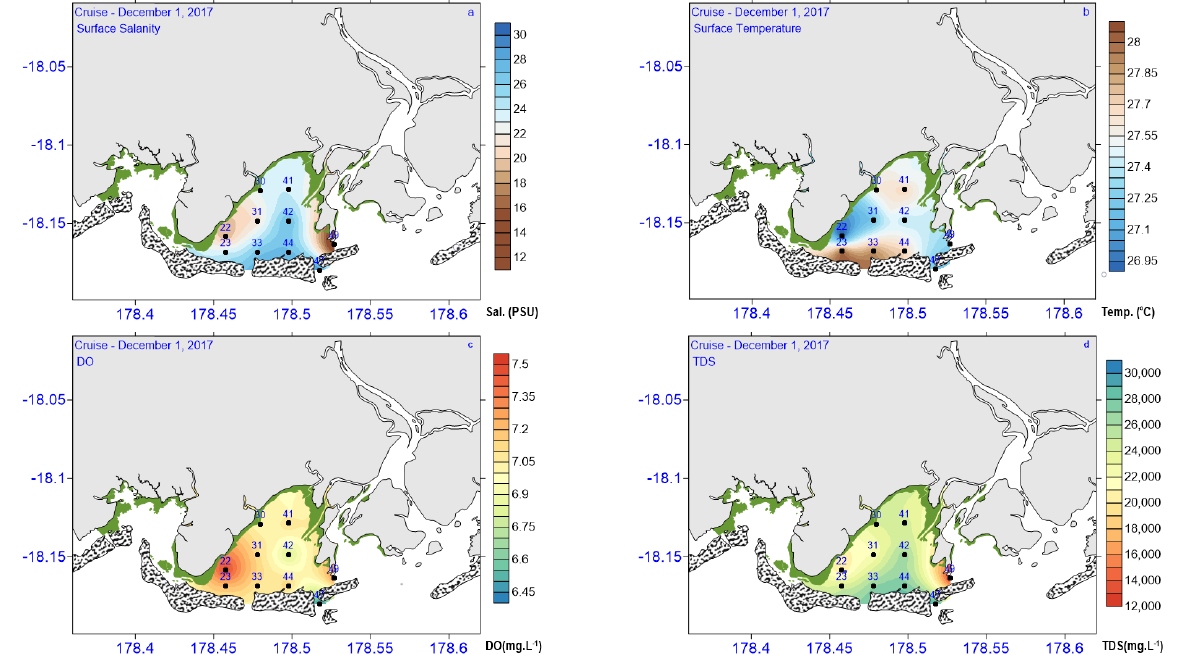
Figure 3. Color maps of ( a ) surface salinity ( b ) surface temperature ( c ) DO and ( d ) total dissolved solids (TDS). Observations from both the surface and bottom temperature obtained from the CTD(depth profiler) and YSI (Yellow Springer Institute) Model 30 handheld water quality meter were similar (not shown). Surface temperature readings from the YSI meter recorded a minimum, maximum, mean of 26.9, 28, 27.5, and a standard deviation of 0.35 ◦ C respec- tively (Table 2) which parallels previous [3] findings where the temperature was expected to be higher in the wet-warm